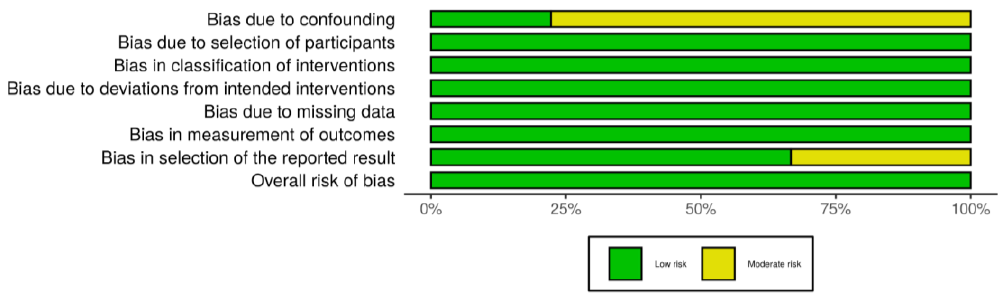
Figure 3. The risk of bias graph: authors’ judgements for each risk of bias reported as percentages across the different studies included in the review.